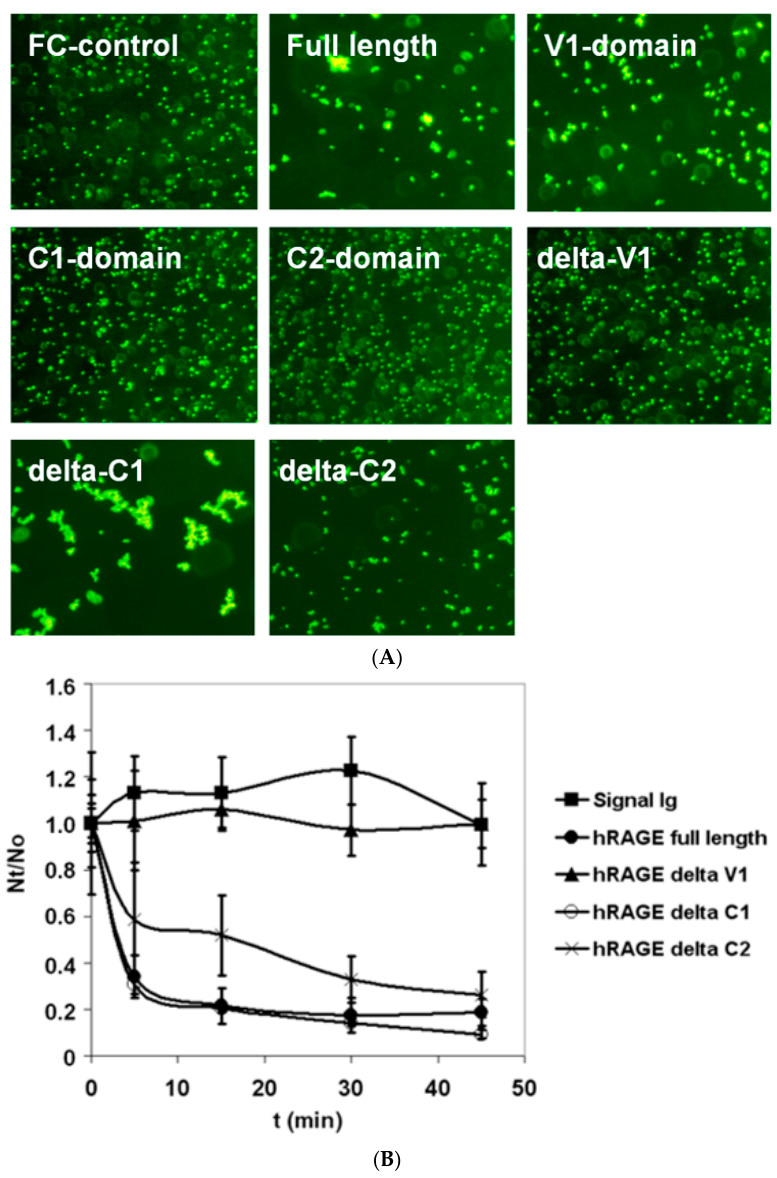
Figure 1. Bead aggregation assay of the receptor for advanced glycation end products (RAGE) homophilic binding. ( A ) Monomeric fluorescent protein A-coated beads were incubated with low concentration (10 μ g/mL) of different Ig-tagged recombinant full length extracellular human RAGE (sRAGE) domains and aggregation was monitored using fluorescence microscopy. The images are taken after 60 min of bead aggregation. ( B ) Kinetics of bead aggregation. N t and N 0 are the total number of particles at incubation times t and 0, respectively. The extent of bead aggregation is represented by the index N t /N 0 . Closed circle curve represents full-length sRAGE–Ig fusion protein, close triangle curve represents sRAGE–Ig fusion protein lacking V 1 -domain, open circle curve represents sRAGE–Ig fusion protein lacking C 1 -domain, cross curve represents sRAGE–Ig fusion protein lacking C 2 -domain, and close square curve represents Fc control protein coated beads. Whereas V 1 -domain was necessary and sufficient for homophilic binding of RAGE, the existence of the C 2 -domain in recombinant sRAGE-fragment was required for maximal homophilic binding of RAGE forms bearing the V 1 - and C 2 -domains. N ≥ 3; error bars represent ±SD.